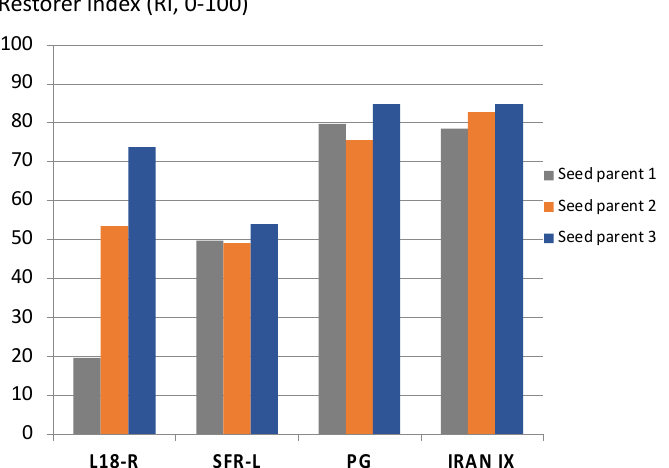
Figure 2. Restorer indices (0–100%) of factorial crosses between four pollinator and three CMS-seed parent lines in P cytoplasm across 3 locations (PG = Pico Gentario; Data source: [38]).